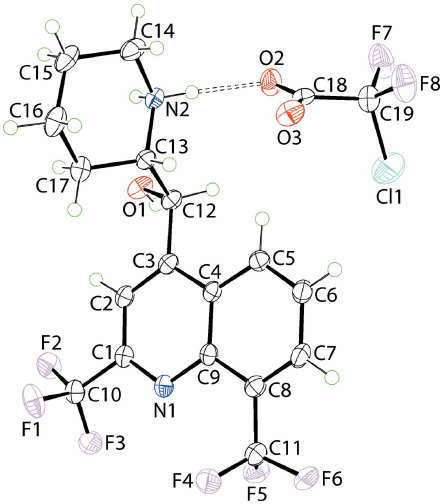
Figure 1 The molecular structures of the ions comprising the asymmetric unit of (I) showing the atom-labelling scheme and displacement ellipsoids at the 70% probability level. The dashed line signifies the N—H (cid:2)(cid:2)(cid:2) O hydrogen bond.